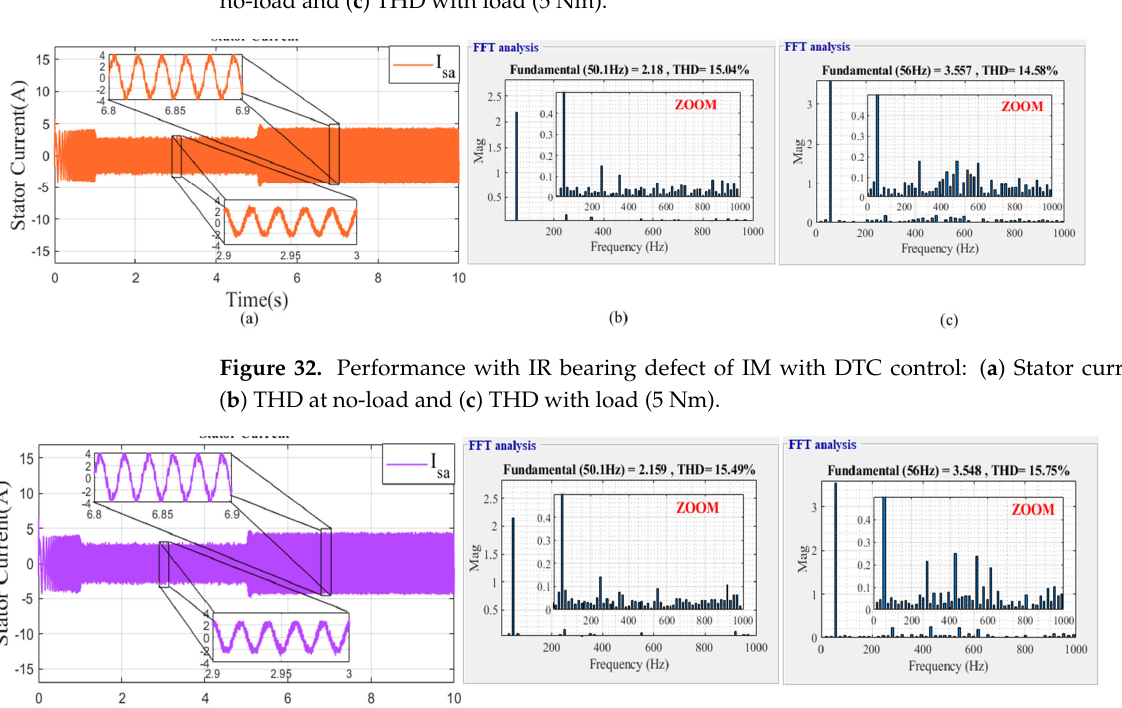
Figure 31. Performance in healthy state of IM with DTC control: ( a ) Stator current and ( b ) THD at no ‐ load and ( c ) THD with load (5 Nm).